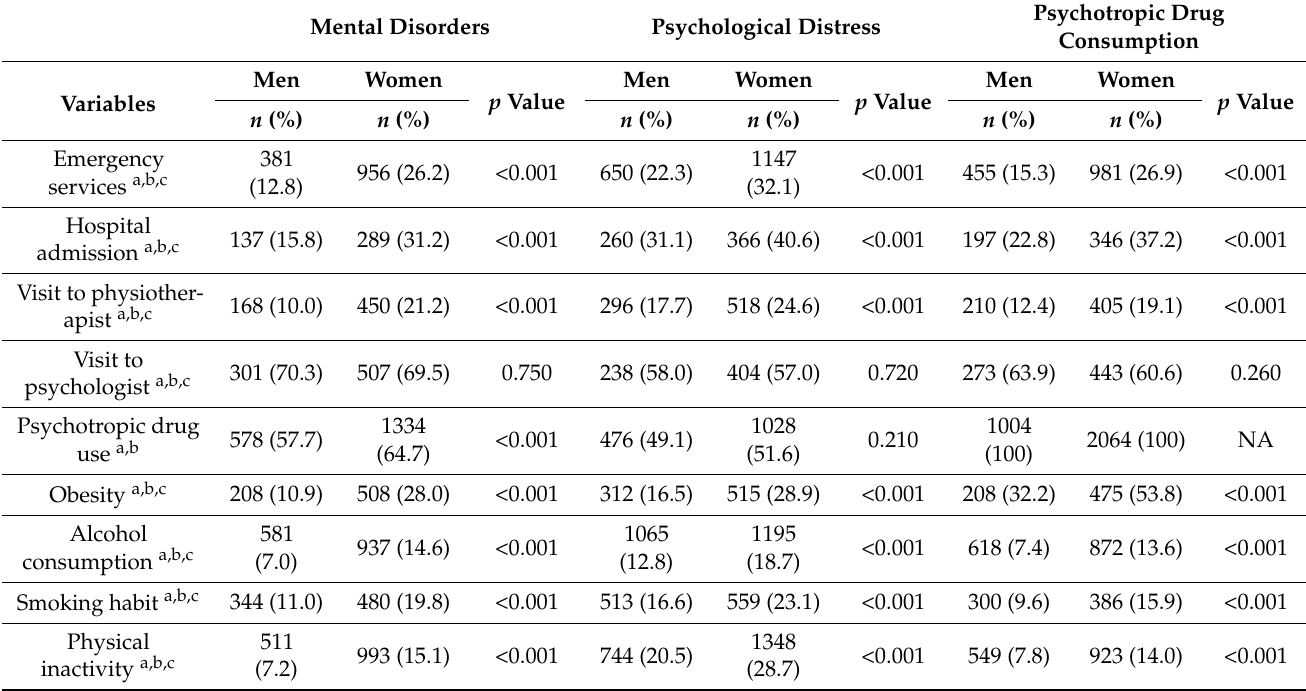
Table 3. Mental disorders, psychologic distress and psychiatric drug consumption according to use of healthcare services and lifestyle-related variables. Results from the Spanish National Health Interview Survey